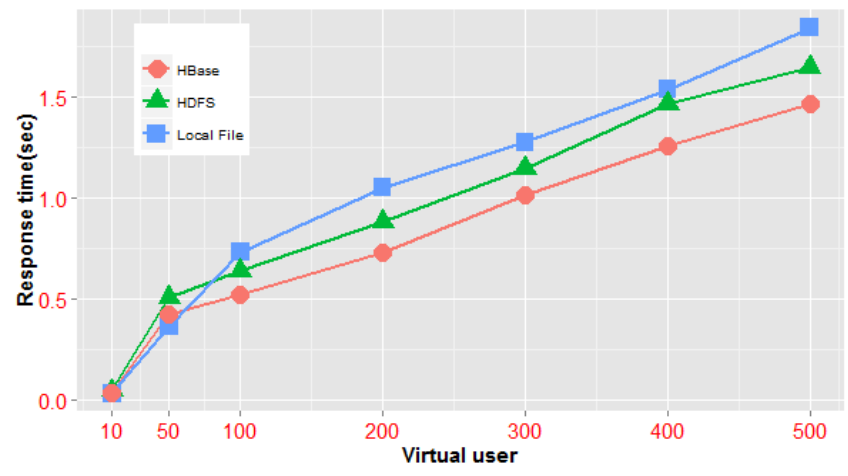
Figure 16. Response time of a single-tile query by concurrent service requests.